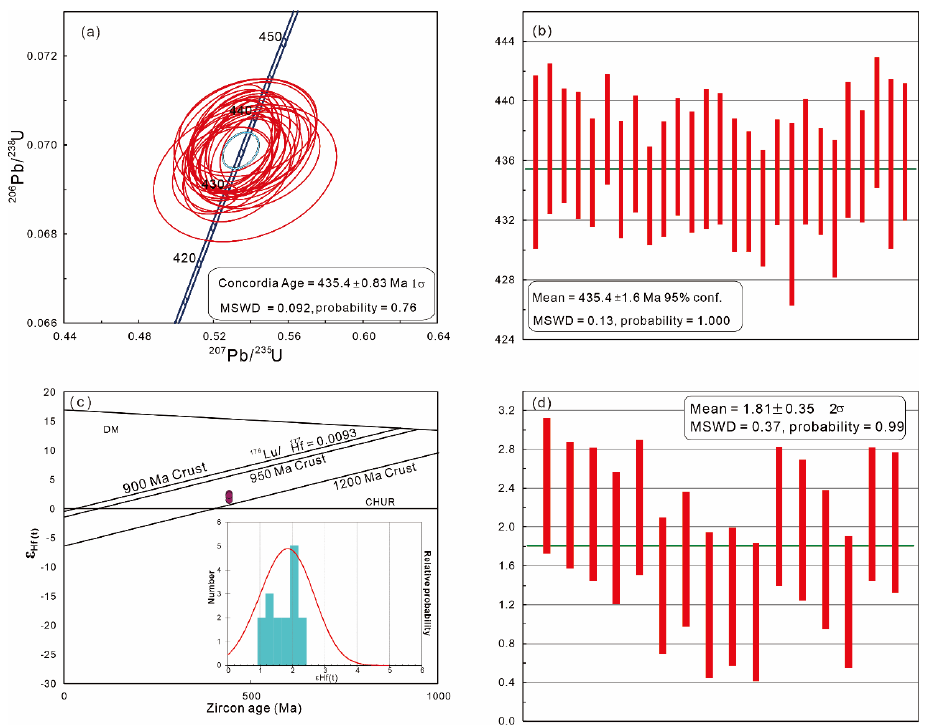
Figure 6. ( a ) for U–Pb concordia diagrams: ( b ) weighted average ages; ( c ) εHf (t) crust evolution diagrams, and ( d ) weighted average εHf (t) values of Yuejingshan gabbro samples. Mean for weighted average ages; MSWD for Mean Standard Weighted Deviation.